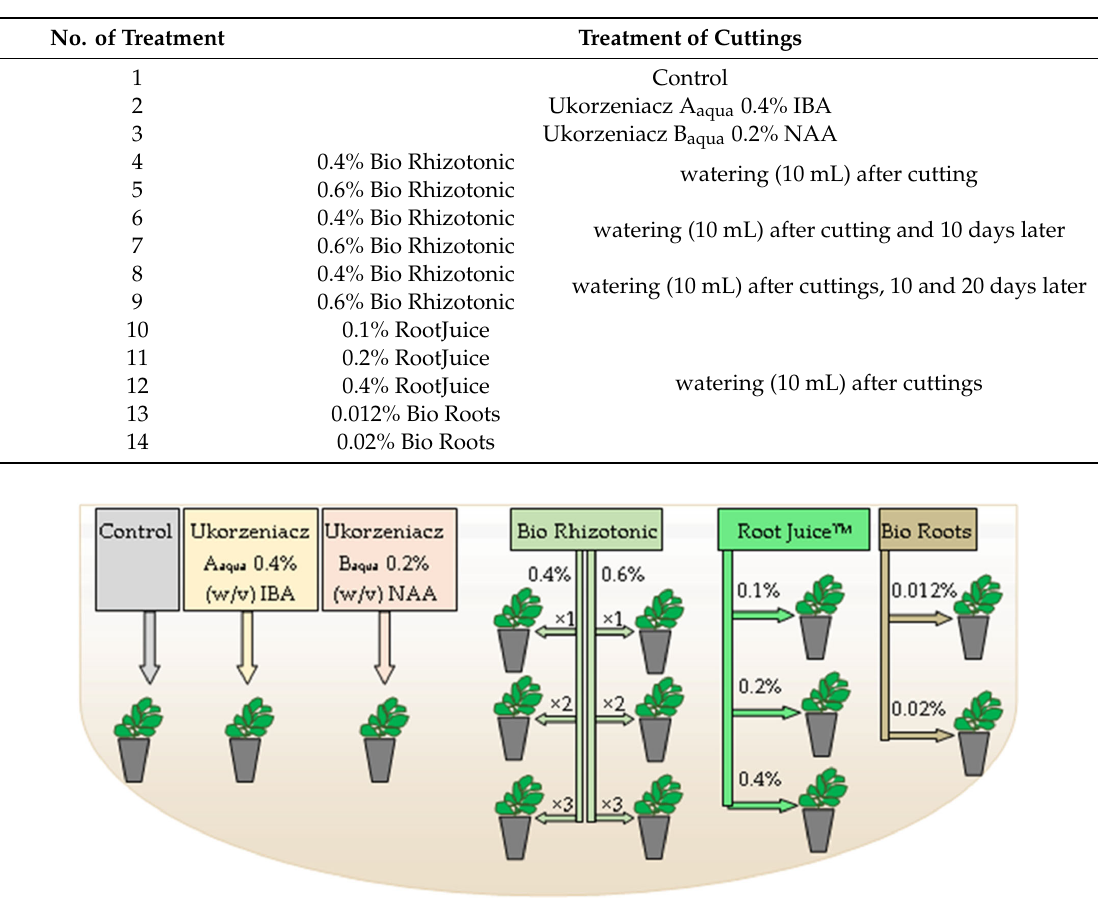
Table 1. Plant origin preparations used to root Rosa ×alba ‘Maiden’s Blush’ in the experiment. Preparation